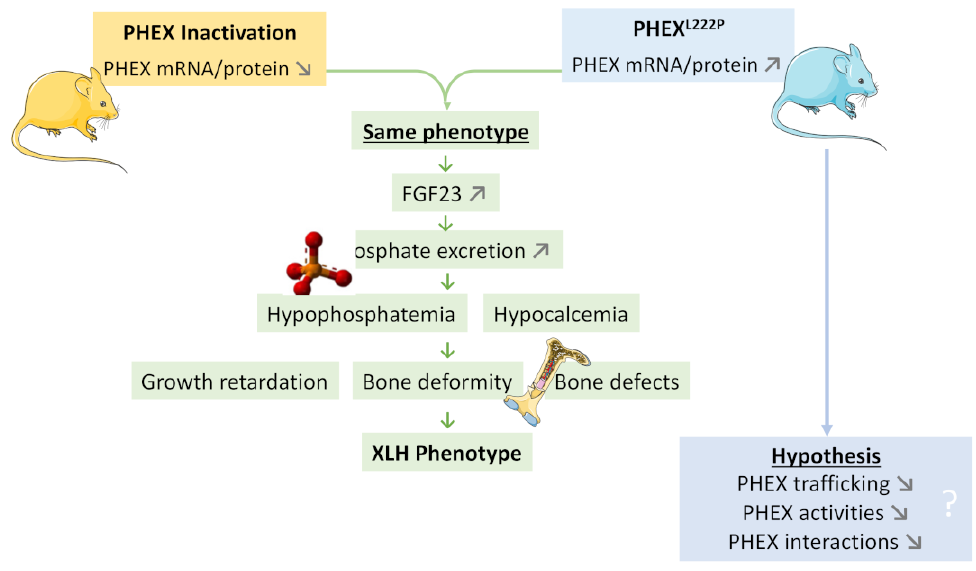
Figure 8. A model highlighting the Phex L222P mutation in a new ENU mouse model for XLH disease. Phex L222P mouse is a new ENU mouse model for XLH disease due to Leu to Pro amino acid modification at position 222 (blue mouse in right). Like PHEX inactivation mouse models (yellow mouse in left), Phex L222P mouse is characterized by growth retardation, hypophosphatemia, hypocalcemia, reduced body bone length, increased epiphyseal growth plate thickness and femur diameter despite the increase in PHEX